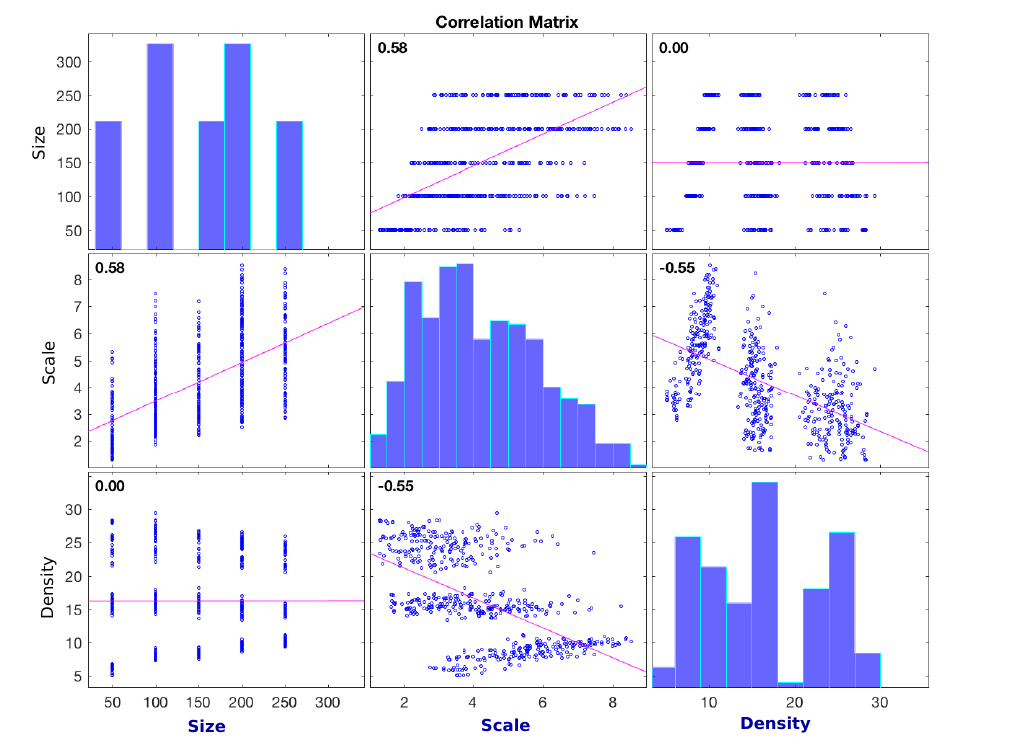
Figure 4. Relationship between physical features in